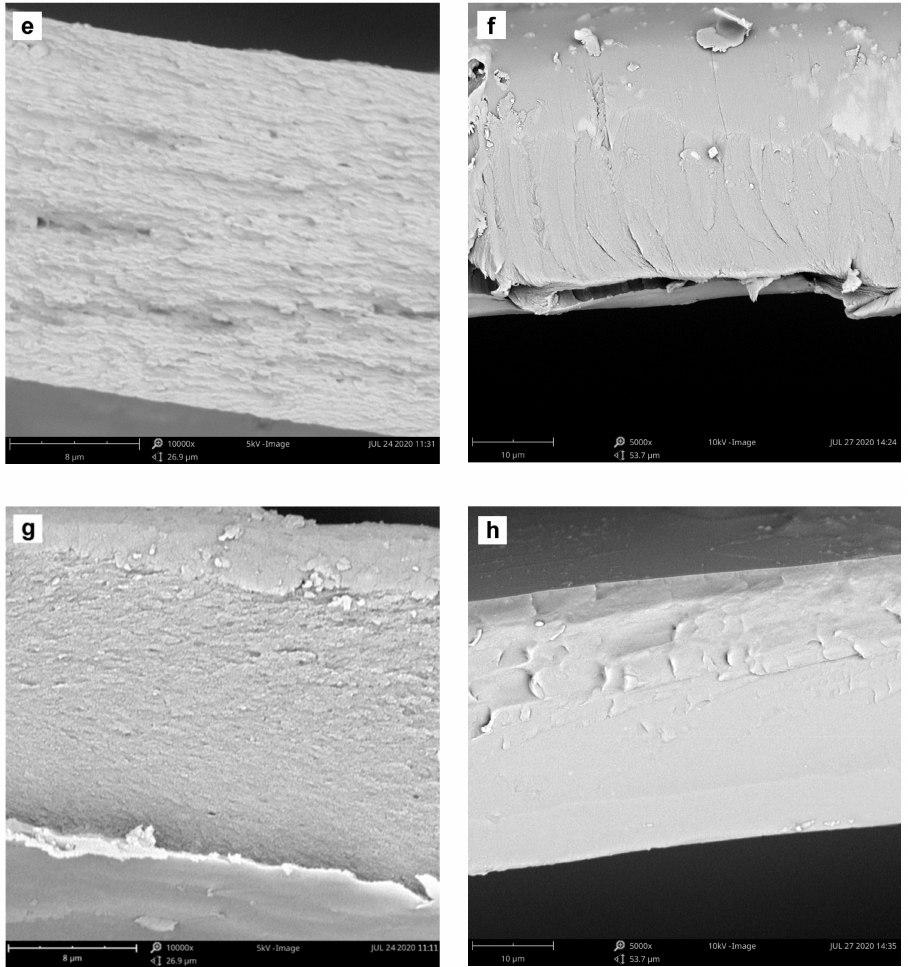
Figure 5. SEM images of the cross-sectional view of ALG (left column) and PVA (right column) membranes filled with 15 wt% of hematite, magnetite or iron(III) acetylacetonate, respectively. Samples were coated with 5 nm layer of Au. Magnification and acceleration voltage: 10,000 × and 5 kV (ALG), and 5000 × and 10 kV (PVA). ( a ) plain ALG; ( b ) plain PVA; ( c ) ALG_Fe 2 O 3 ; ( d ) PVA_Fe 2 O 3 ; ( e ) ALG_Fe 3 O 4 ; ( f ) PVA_Fe 3 O 4 ; ( g ) ALG_Fe(acac) 3 and ( h ) PVA_Fe(acac)